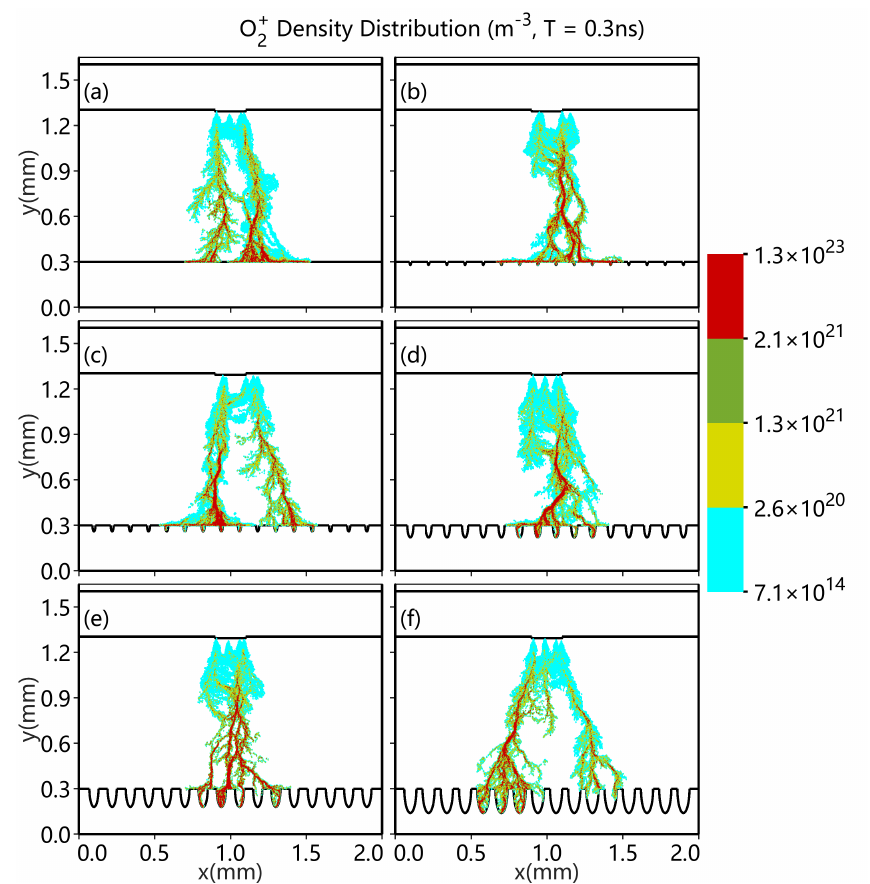
Figure 5. O + densities (m − 3 ) of different catalyst pore sizes at 0.3 ns in DBD with ε r = 4 for both the 2 top and bottom dielectric plates. The bottom dielectric plate has 16 pores. The sizes of the catalyst pores are 0.0 × 0.0 ( a ), 0.01 × 0.02 ( b ), 0.02 × 0.04 ( c ), 0.04 × 0.08 ( d ), 0.06 × 0.12 ( e ), and 0.08 × 0.16 mm ( f ). The voltage of the upper electrode ( y ∈ [ 1.60,1.65 ] mm) is − 20 kV, and the bottom electrode ( y = 0 mm) is